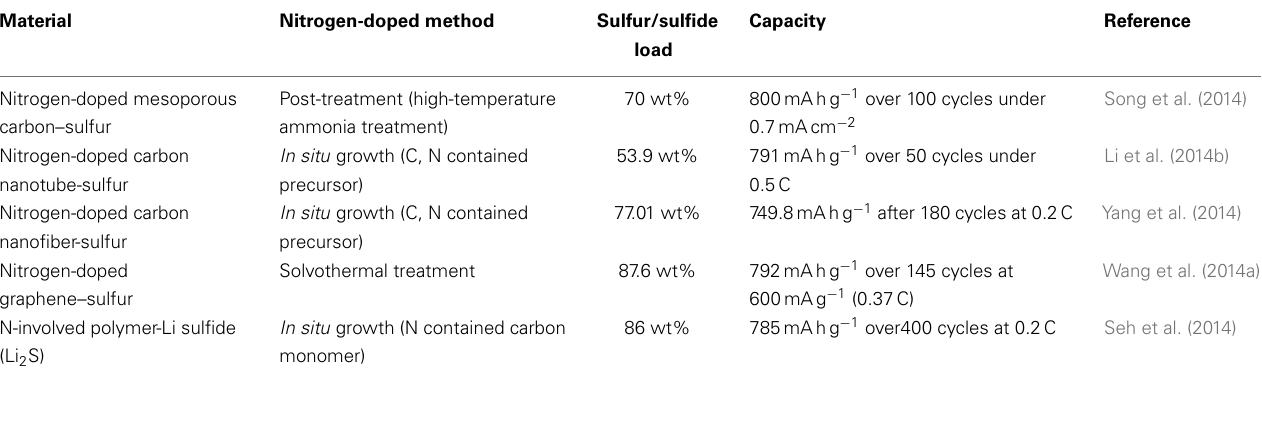
Table 2 | Summary of nitrogen-doped carbons in Li–S system in terms of synthetic method, sulfur load, and electrochemical performance .